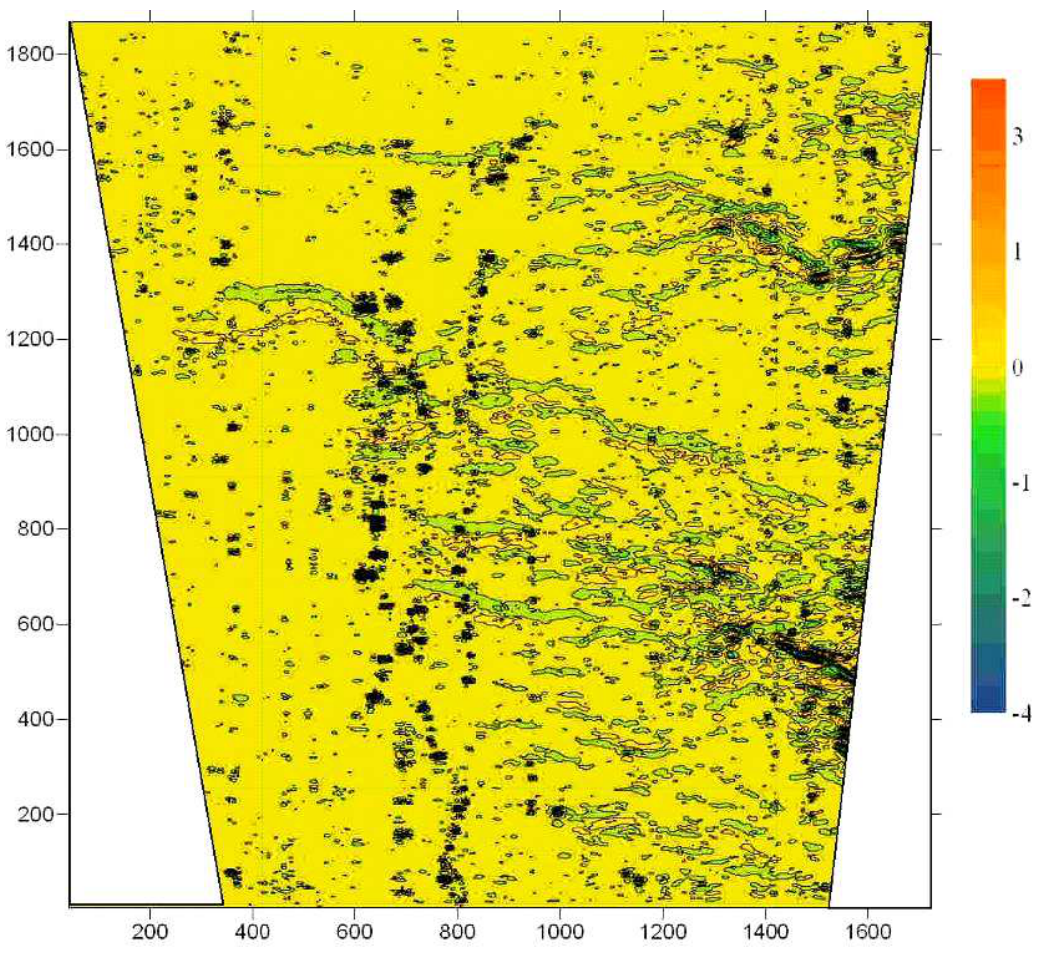
Figure 8. Band pass filtered magnetic map of survey